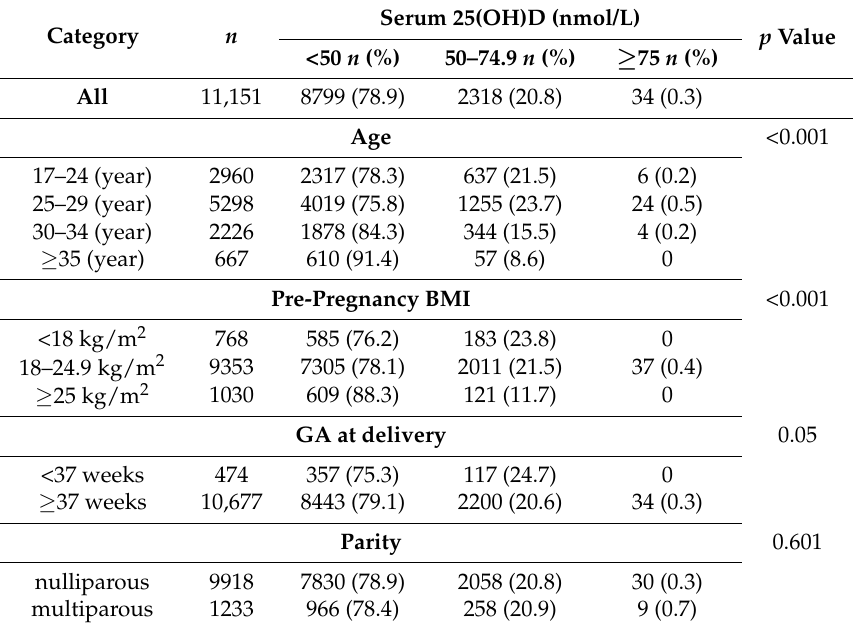
Table 2. The serum 25(OH)D concentration of pregnant women according to categories of relevant confounding variables.